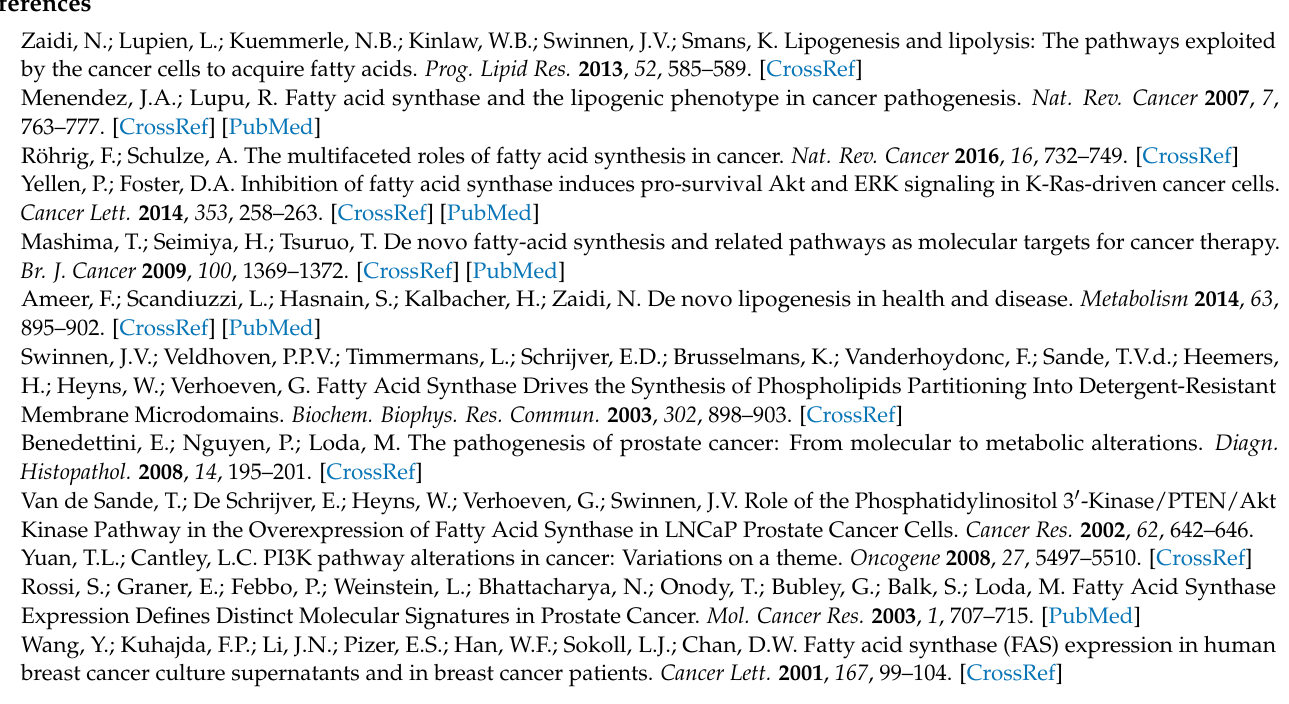
Figure S5. Comparison of viability of LNCaP and PC3 cells treated with A. GSK2194069 or B. 2 (right); Figure S6. Comparison of [ 11 C]5 binding to LNCaP cells cultured for >48 h (black) and <48 h